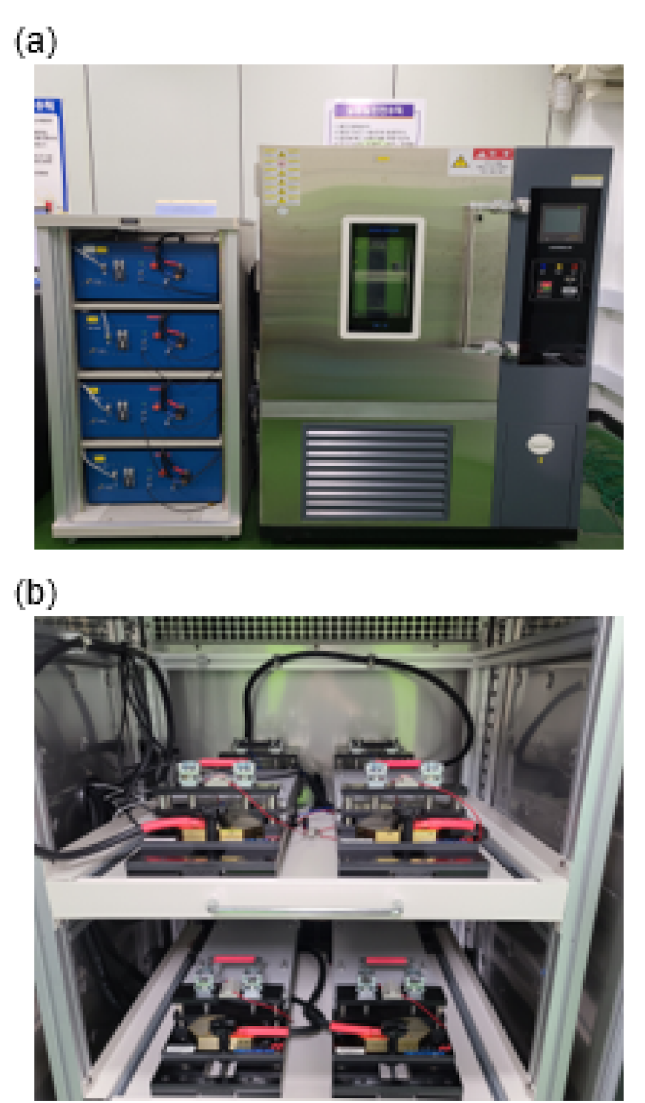
Figure 2. ( a ) Test system, ( b ) Pressure jig. Through a number of battery experiments, data analysis and electrochemical char- acterization were performed. For this, the discharge capacity based on current counting was measured through the constant current (CC) discharge and CC-constant voltage (CV) charge method. The CV experiment ends as the current reaches 2.78 A (1/20 C). To measure the discharge capacity, 0.5 C current was applied up to the full discharge voltage at 100% state of charge (SOC), and an hour of rest was given between the discharge mode and charge mode for the electrochemical equilibrium to be achieved. Next, at 100% SOC, 0.5 C current was applied up to the capacity (Ah) corresponding to 50% SOC, and at 50% SOC, an hour of rest was given for the equilibrium to be achieved. Subsequently, the IR